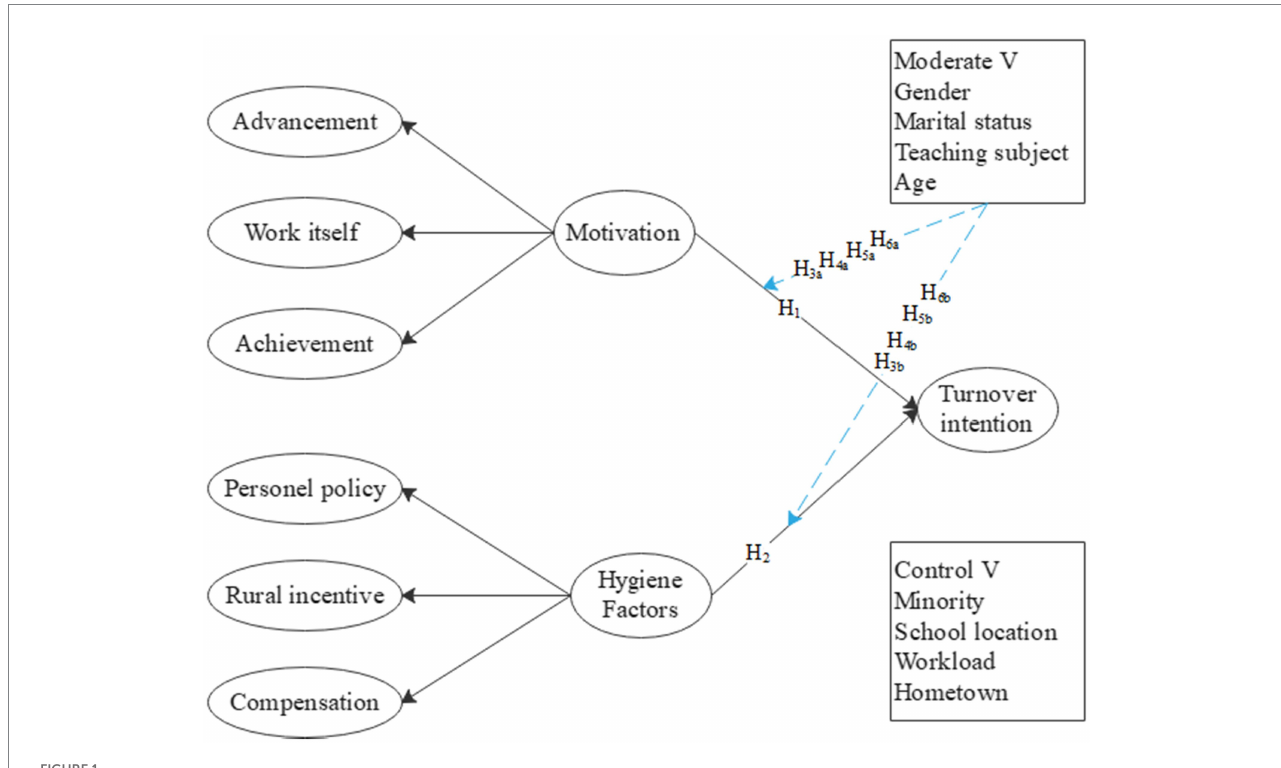
FIGURE 1 Research